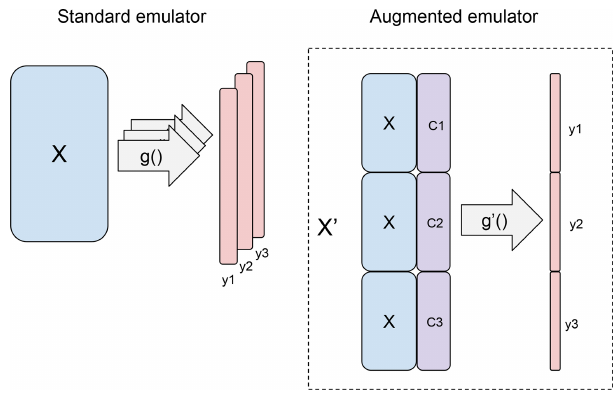
Figure 5. In a standard emulator setup (left), training data consist of an input matrix X and corresponding simulator output y . A new em- ulator g 1 (),...,g 3 () is trained for each output y 1 ,..., y 3 of interest. In the augmented emulator, output from the simulator C 1 ,..., C 3 augments the design matrix, with the initial inputs X repeated.